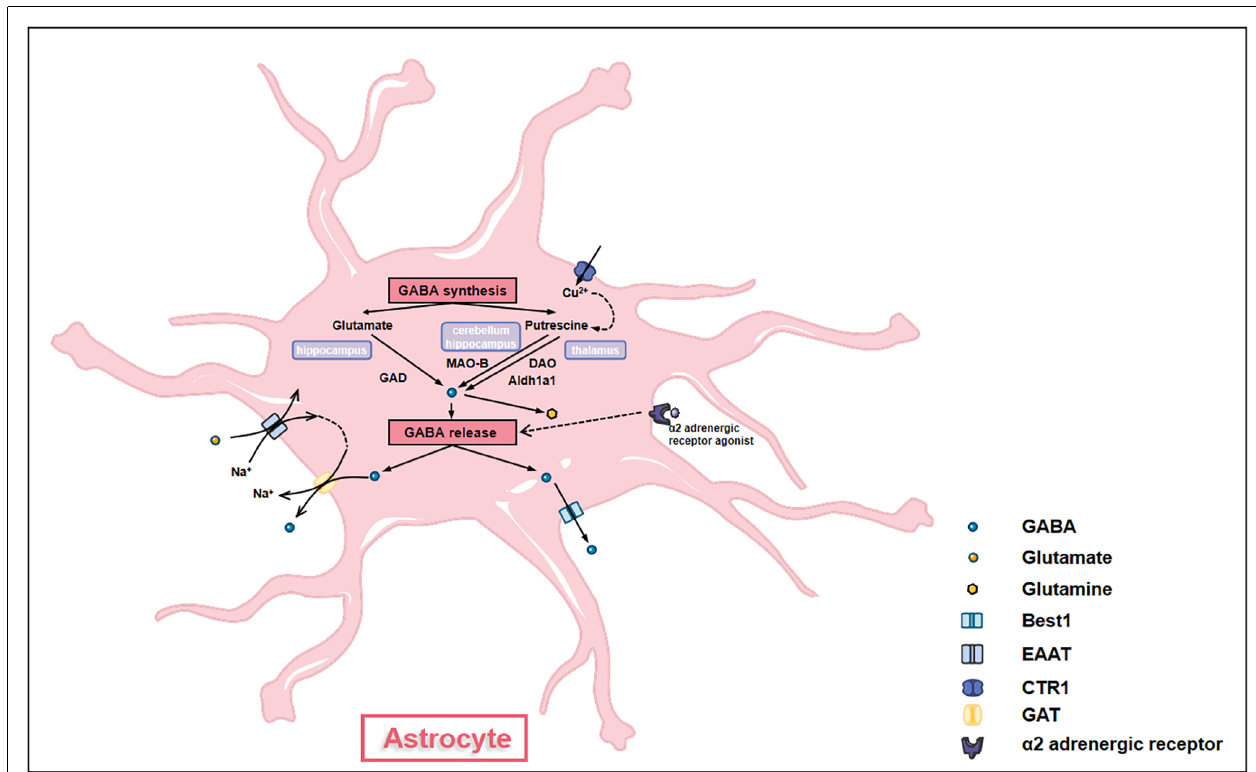
FIGURE 3 | Astrocytes synthesize and release GABA. GABA synthesis in astrocytes has different pathways in different brain regions. In the hippocampus, glutamate in astrocytes is converted into GABA under the action of glutamate acid decarboxylase (GAD). In the cerebellum and the hippocampus, putrescine in astrocytes is converted into GABA under the action of monoamine oxidase B (MAO-B). In the thalamus, putrescine in astrocytes generates GABA through a two-step interaction of diamine oxidase (DAO) and aldehyde dehydrogenase 1 family A1 (Aldh1a1). The transformation of putrescine to GABA is affected by the levels of intracellular copper ion which is regulated by copper transporter (CTR). GABA synthesized by astrocytes can be further converted into glutamine to enter glutamine-glutamate cycle. GABA is released out of cells by either GABA transporter proteins (GATs) under the action of glutamate transporter (EAAT) or through bestrophin (Best1). α -2 adrenergic receptors also modulate the release of GABA through G i βγ subunit-associated signaling